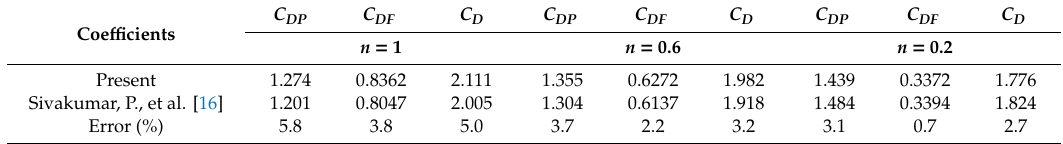
Table 3. Numerical values of drag coe ffi cients with power-law analysis around a circular obstacle. Coe ffi cients Present